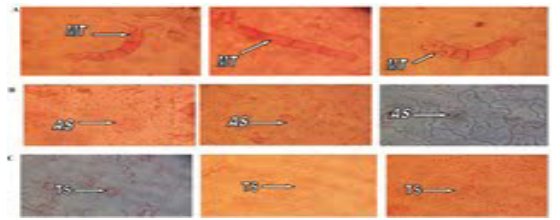
Fig. 1. Leaf epidermal features of A. hybridus showing (A) mul- ticellular trichome (MT), (B) anisocytic stomata (AS) and (C) tetracytic stomata (TS).